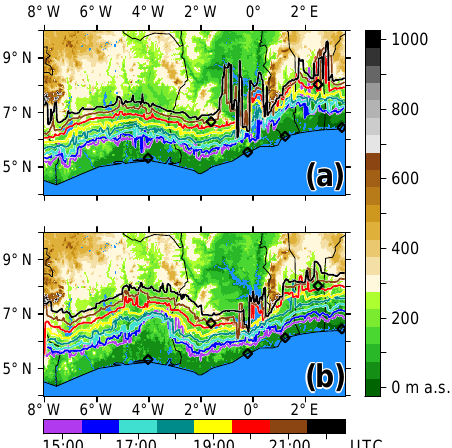
Figure 7. Localization of the AI front on (a) 2 July 2016 and (b) 3 July 2016 between 15:00 and 22:00UTC for the reference case. The front is detected by the arrival of the isentropic surface θ s = 302K at h s = 250ma.g.l.. The color of the front denotes the time (UTC, bottom legend). The underlying shading shows the to- pography of SWA (ma.s.l., legend on the right). The black dia- monds denote the cities shown in Fig. 1.